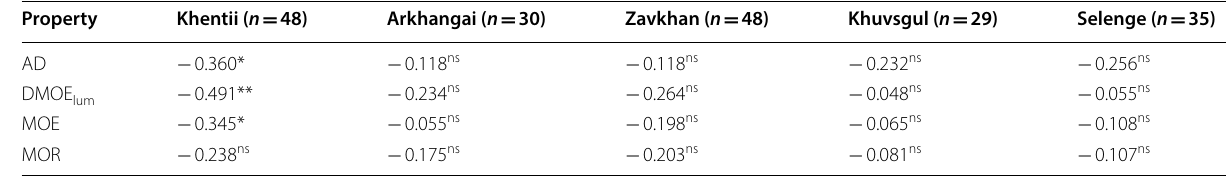
Table 7 Correlation coefficients between annual ring width and lumber properties in each stand